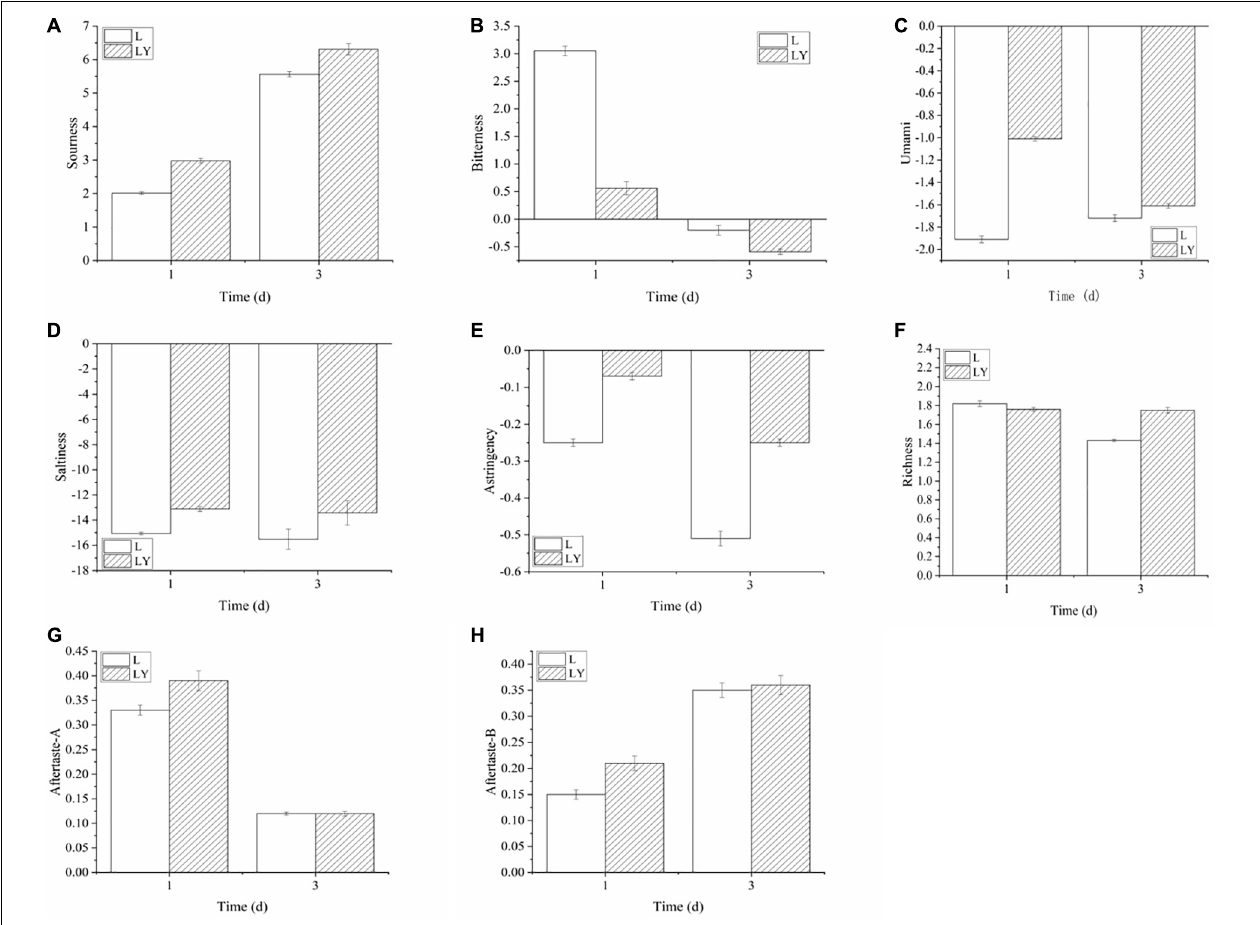
FIGURE 3 | The variations of taste signal value of taste substances in the fermentation period of 1 and 3 days of rice-acid inoculated with L. paracasei and mixed-culture with L. paracasei and K. marxianus [L means rice-acid inoculated with L. paracasei , LY means rice-acid inoculated with L. paracasei and K. marxianus . Taste substances include sourness (A) , bitterness (B) , umami (C) , saltiness (D) , astringency (E) , richness (F) , aftertaste-A (G) , and aftertaste-B (H) ].